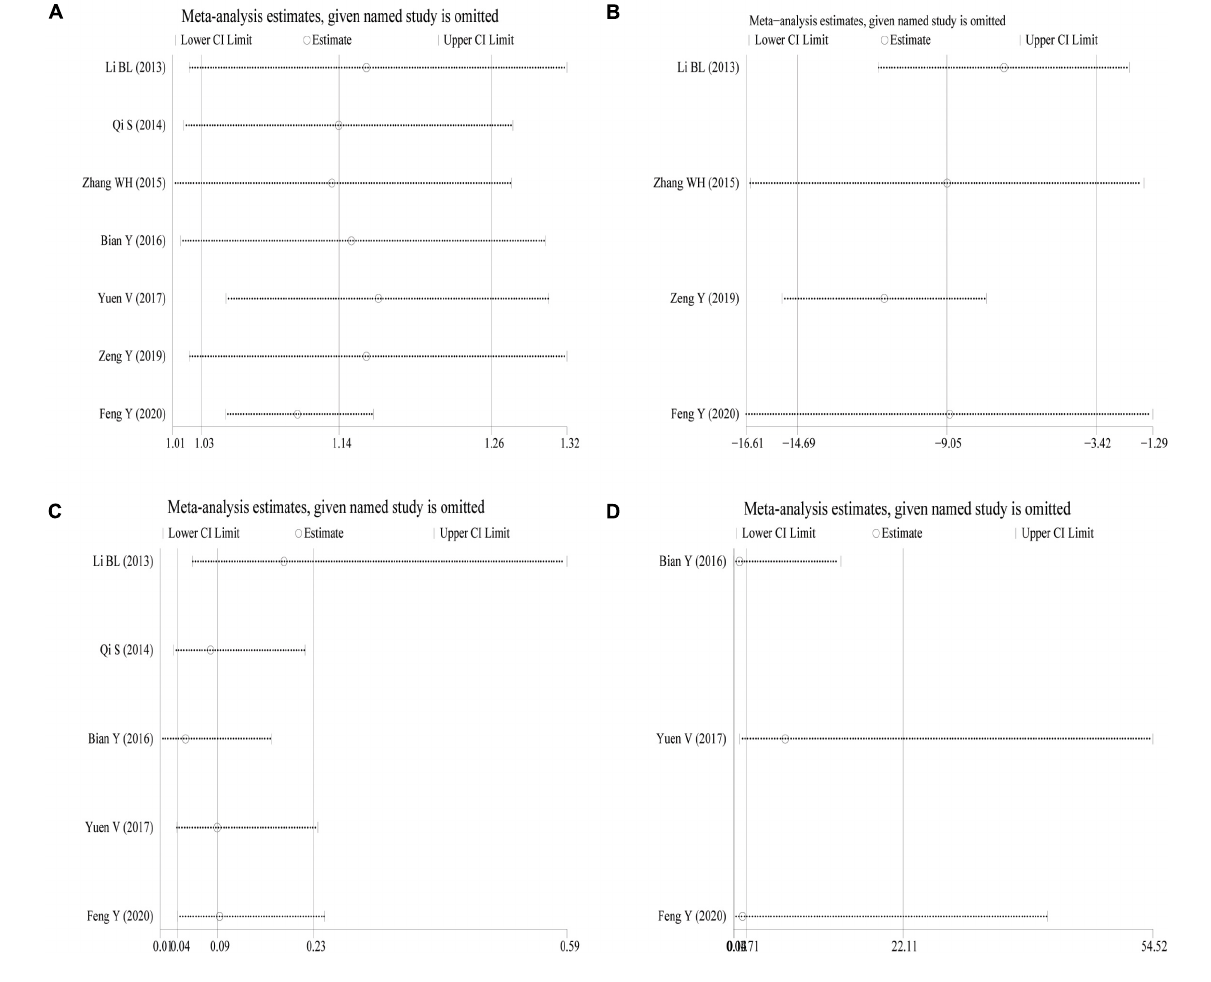
FIGURE 5 | Sensitivity analysis. (A) Success rate of sedation; (B) duration of sedation; (C) incidence of nausea and vomiting; (D) incidence of